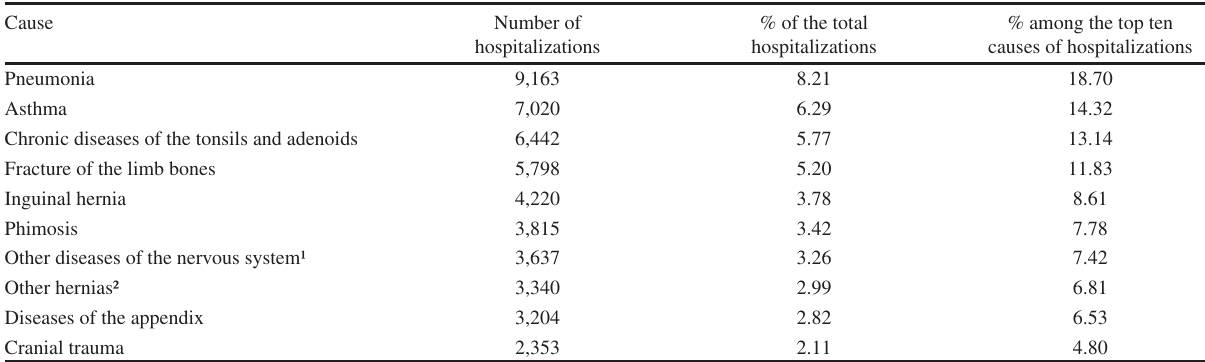
Table 5 - The top ten main causes of hospitalizations for in children between five and nine years old in the city of São Paulo during the five years studied, 2002 to 2006